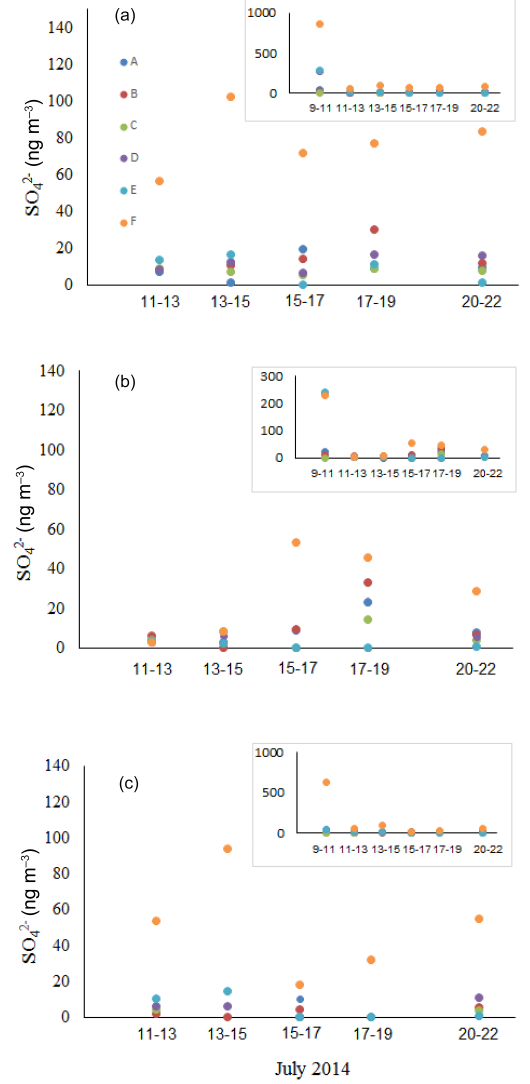
Figure 6. Non-sea salt (a) , anthropogenic (b) and biogenic (c) sul- fate concentrations for size-segregated aerosols in the Arctic and subarctic. Strictly speaking, Arctic samples include those collected after 13 July. Inserts contain the first sampling period (9–11 July) in the Gulf of St Lawrence.